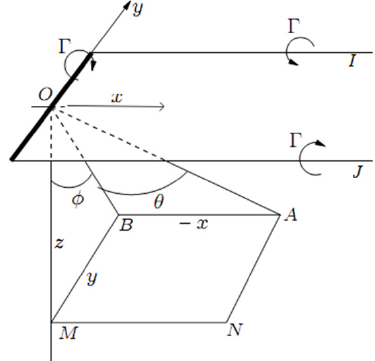
Figure 2. Induced velocity at a point by a horseshoe vortex.